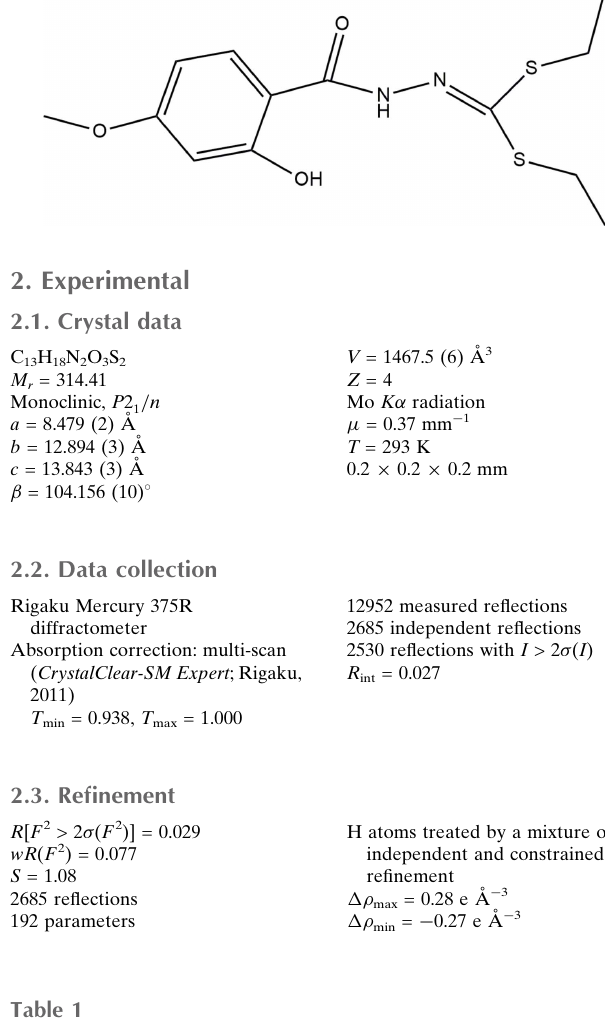
Hydrogen-bond geometry (A˚ , (cid:2)